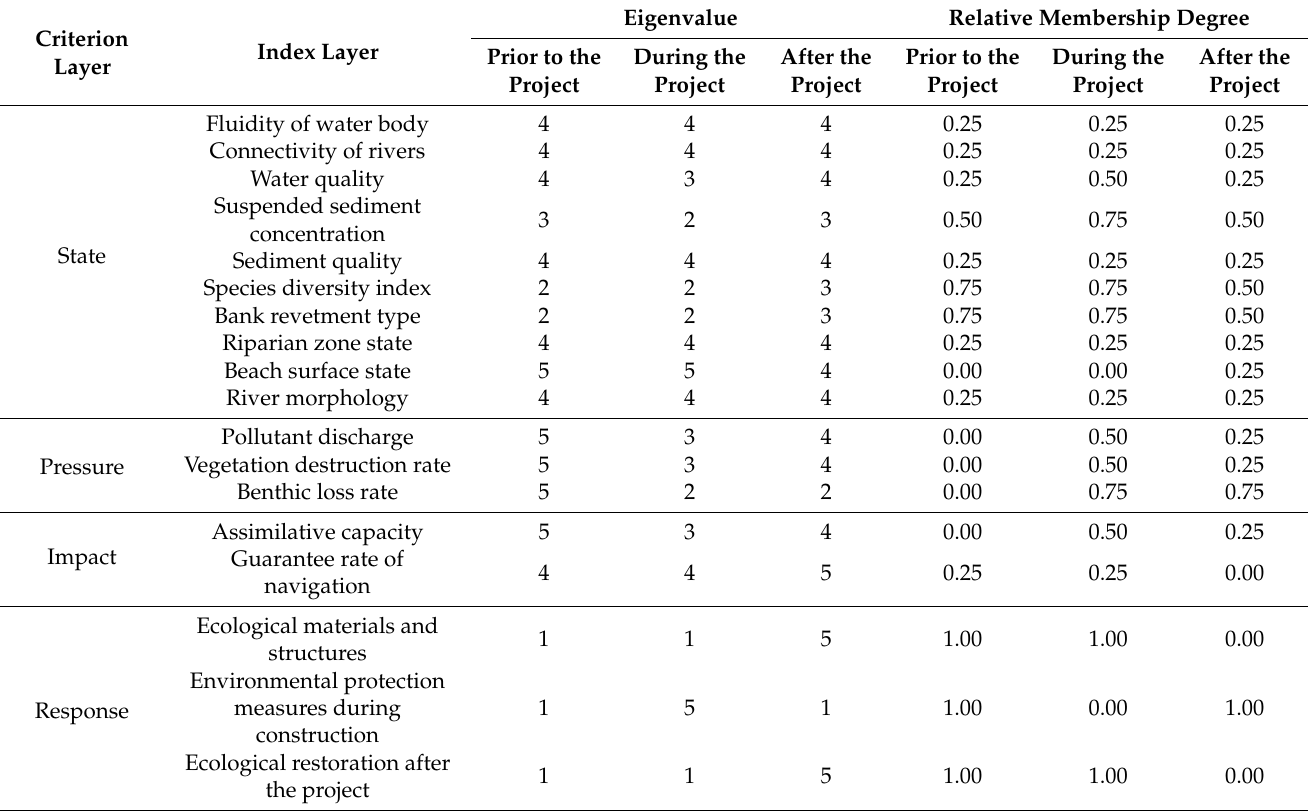
Table 3. Normalized index eigenvalue and relative membership degree.